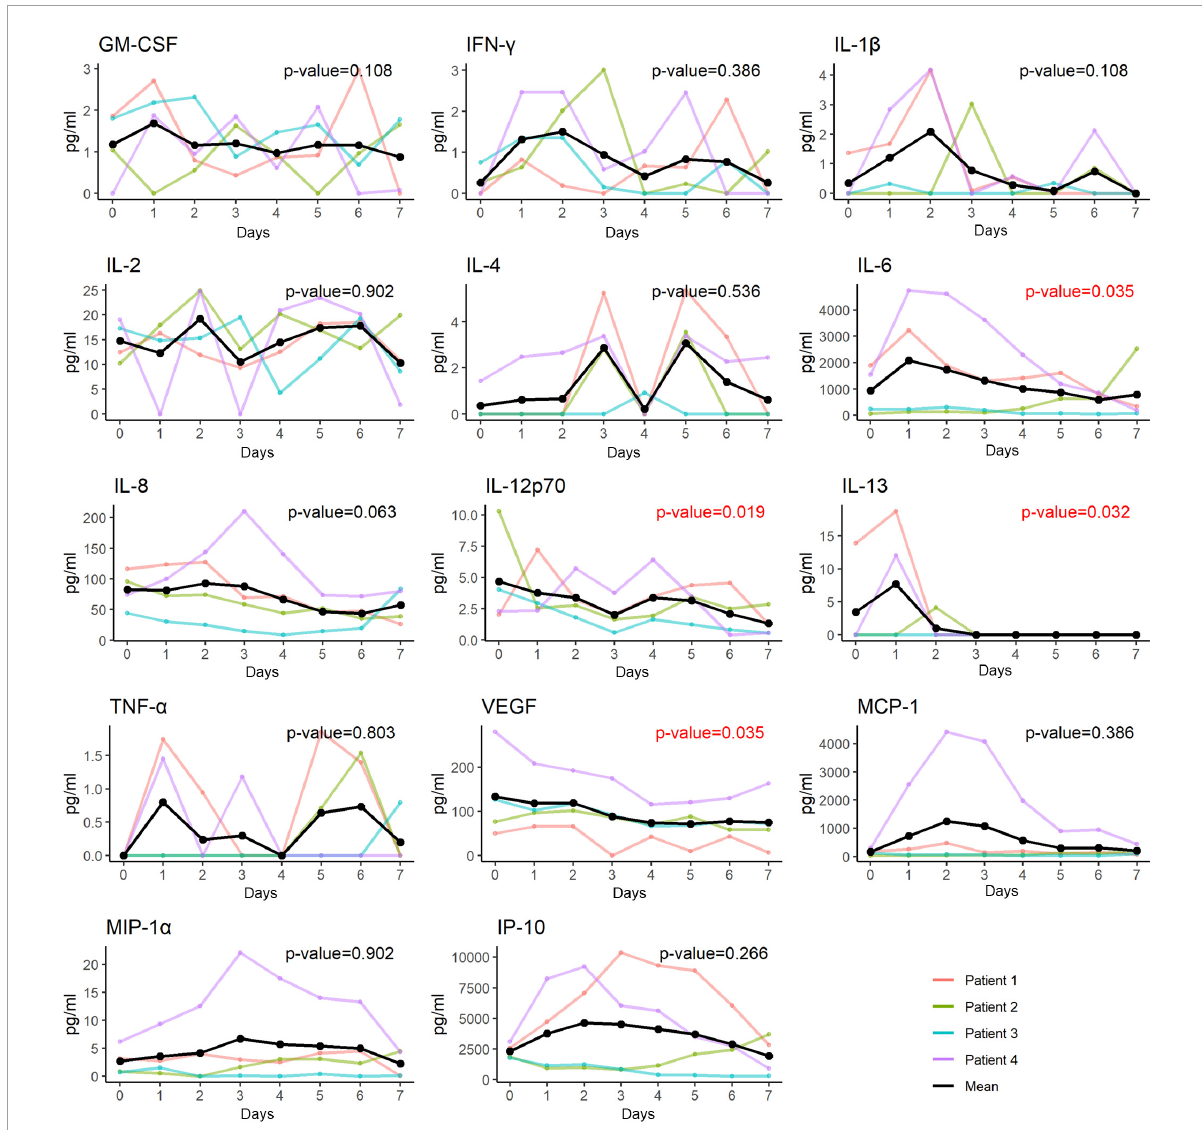
FIGURE6 Changes of plasma levels of cytokines and chemokines in patients receiving hUC-MSC intervention. The plasma levels of 4 out of the 14 inflammatory cytokines including IL-6, IL-12p70, IL-13 and VEGF had a significant decrease in trend after receiving the hUC-MSC transplantation. GM-CSF, granulocyte-macrophage colony-stimulating factor; IFN, interferon; IL, interleukin; IP, interferon-gamma-inducible protein; MCP, monocyte chemoattractant protein; MIP, macrophage inflammatory protein; TNF, tumor necrosis factor; VEGF, vascular endothelial growth